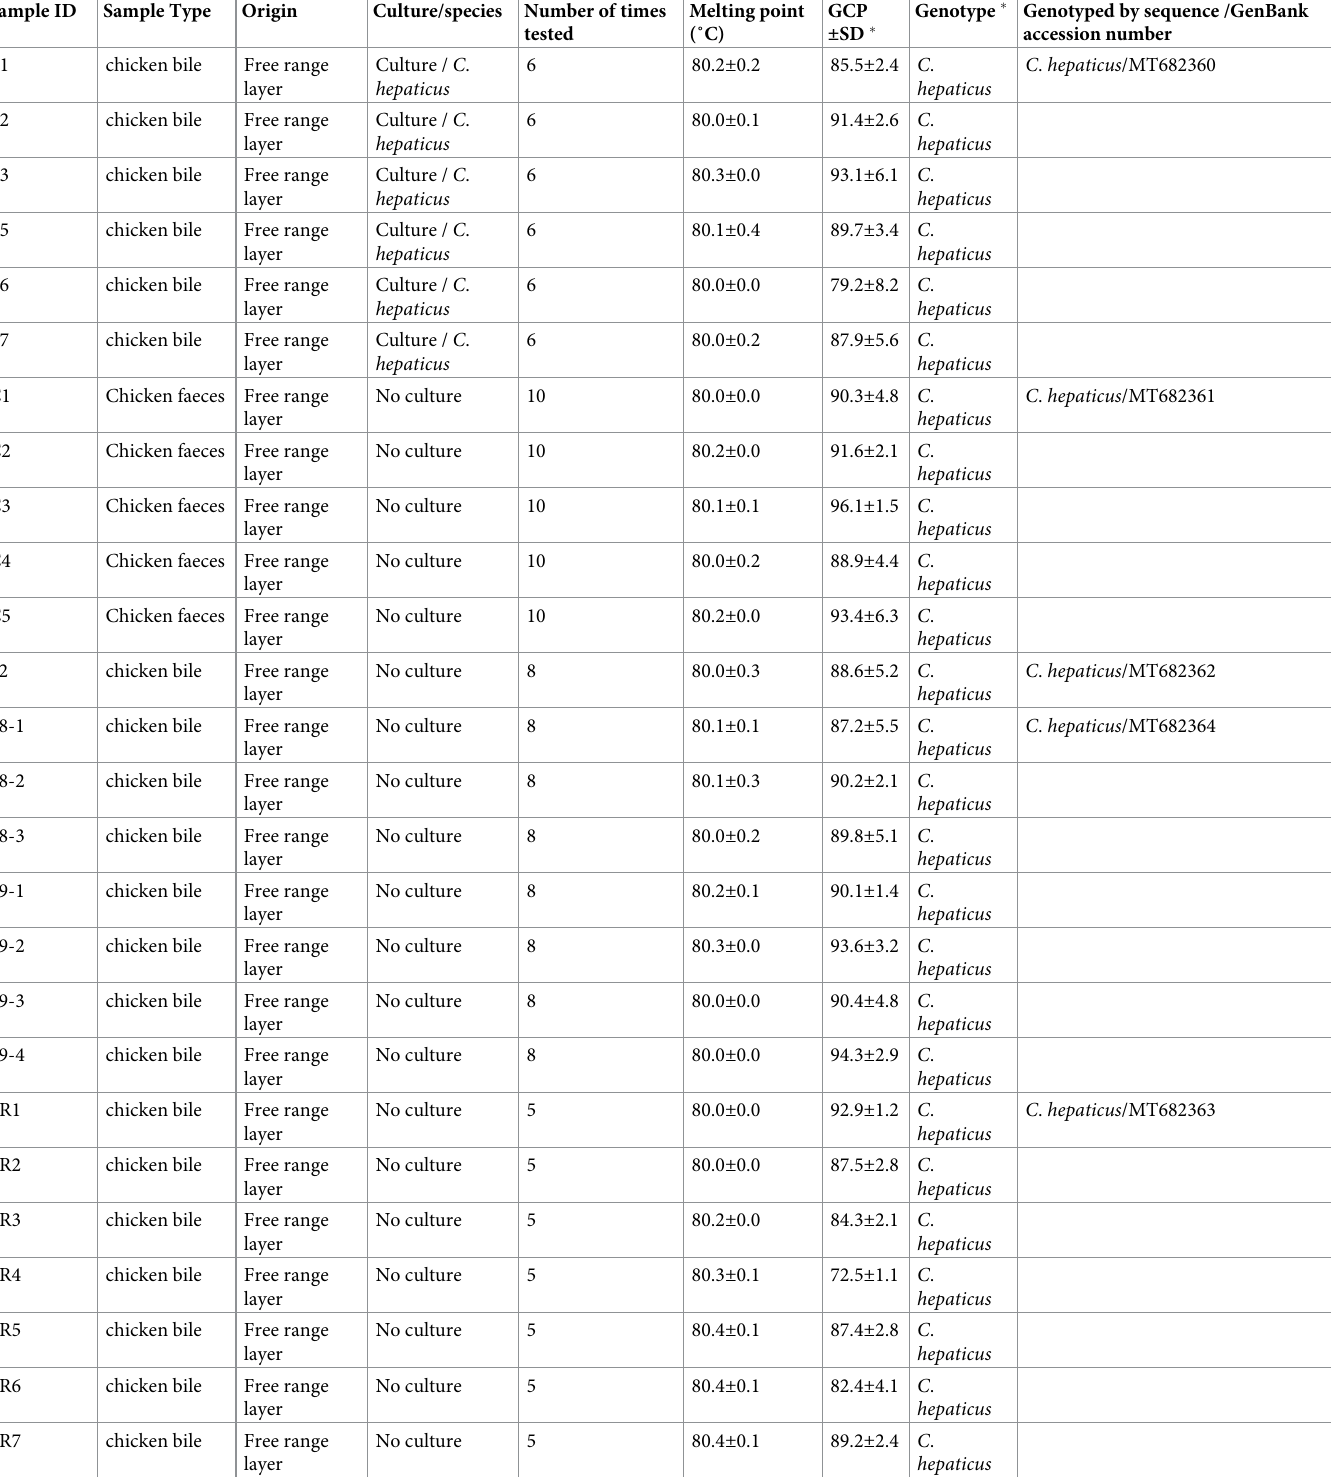
Table 1. List of samples, origins, mean curve peak melting points ± SD, submitted GenBank accession numbers and genotypes of samples tested using PCR- HRM curve analysis. Sample